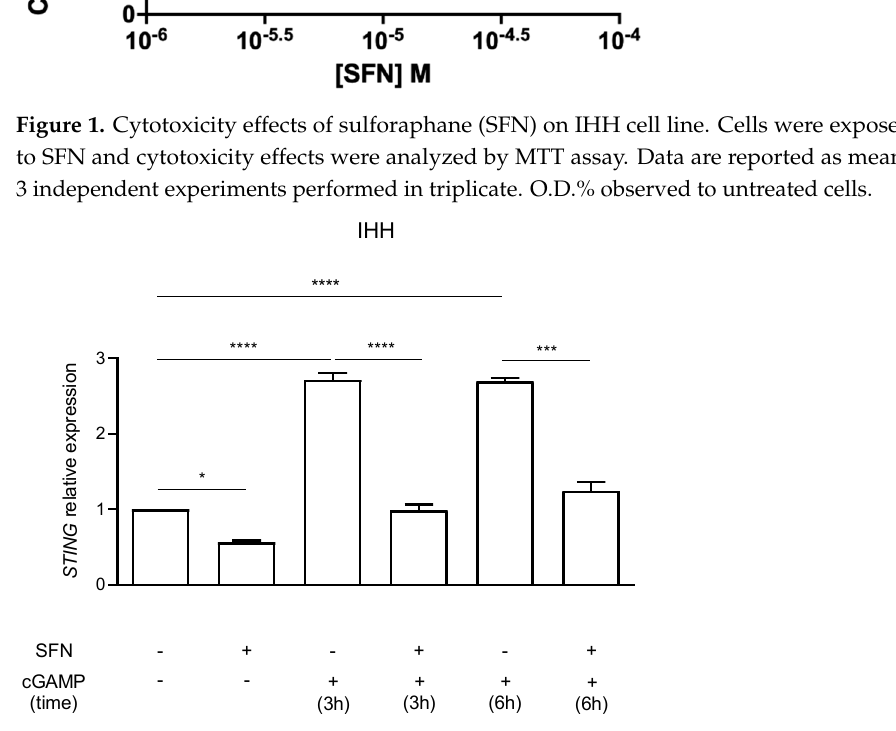
Figure 1. Cytotoxicity effects of sulforaphane (SFN) on IHH cell line. Cells were exposed for 72 h to SFN and cytotoxicity effects were analyzed by MTT assay. Data are reported as means ± SE of 3 independent experiments performed in triplicate. O.D.% observed to untreated cells.